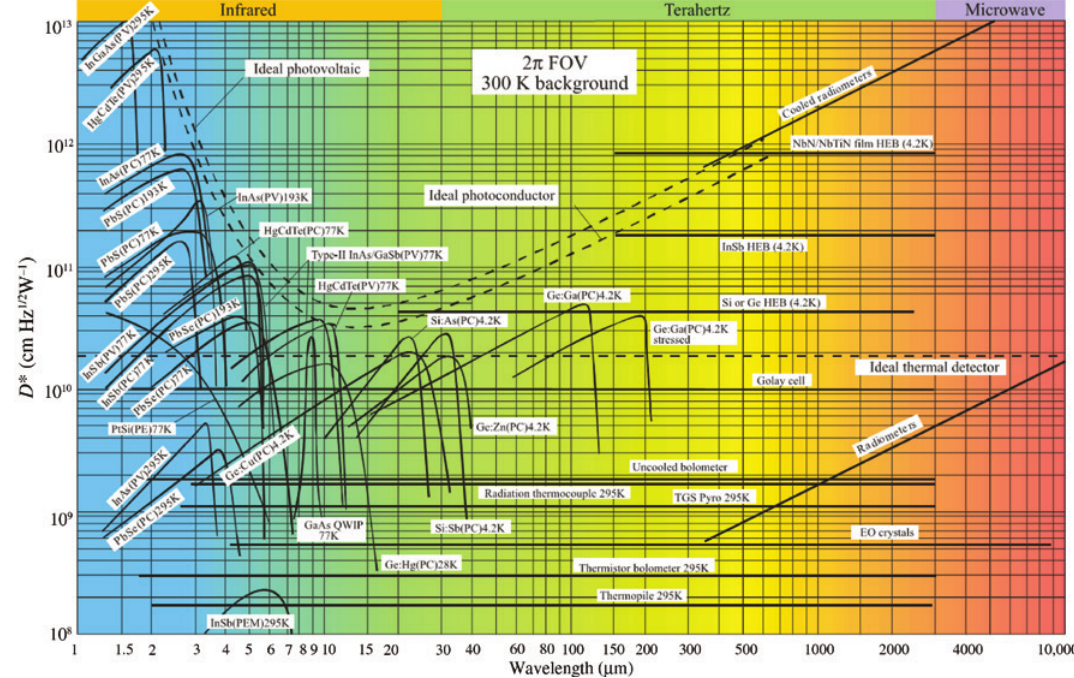
Figure 1: Comparison of the detectivity of various available detectors when operated at the indicated temperature. Theoretical curves for the background-limited D * (dashed lines) for ideal photovoltaic and photoconductive detectors and thermal detectors are also shown. HEB, hot electron bolometer; PC, photoconductive detector; PEM, photoelectromagnetic detector; PV, photovoltaic detector